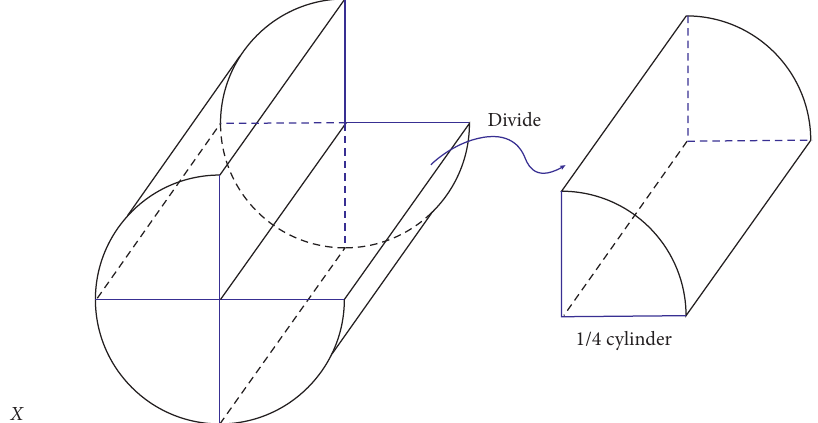
Figure 7: Rotor shaft divided into four parts and 1/4 cylinder.